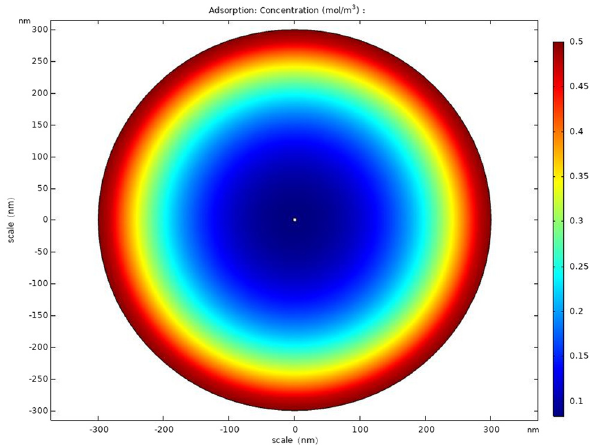
Figure 6: Distribution of the NH 3 concentration in the Ag - CNFs surface simulated by